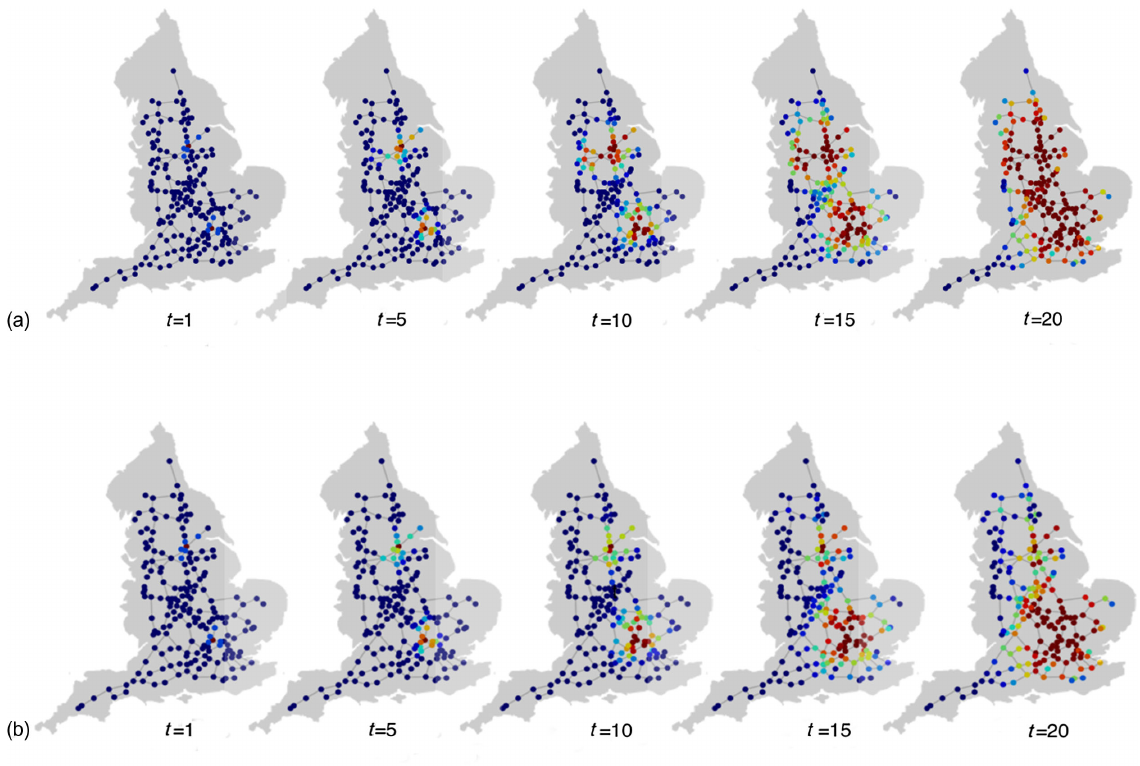
FIG. 8. England road network — the collaborative spread of highly infectious coupled processes. We consider the spread of highly infectious coupled processes through the road network starting from the areas of Greater London (node 10, process A ) and Leeds (node 11, process B ); the budget for both A and B is one unit, and infection parameters are α A ¼ α B ¼ 0 . 2 , α BA ¼ α AB ¼ 0 . 99 . The process runs for 20 steps. The vaccination budget is one unit per time step and is effective to suppress process B only while being ineffective for process A . The node color represents the value of 1 − P i S ð t Þ , where red and blue correspond to 1 and 0, respectively (the heat bar is similar to that of Fig. 6). (a) Free spread of the epidemics with no vaccination. (b) Vaccination budget of one unit per time step against process B deployed at each time step using the DMP-optimal algorithm. We see that in panel (b), the infection in the London area spreads unhindered in both (a) and (b), as it is mainly infected by process A , while spread emanating from the Leeds area is effectively blocked when the vaccination is